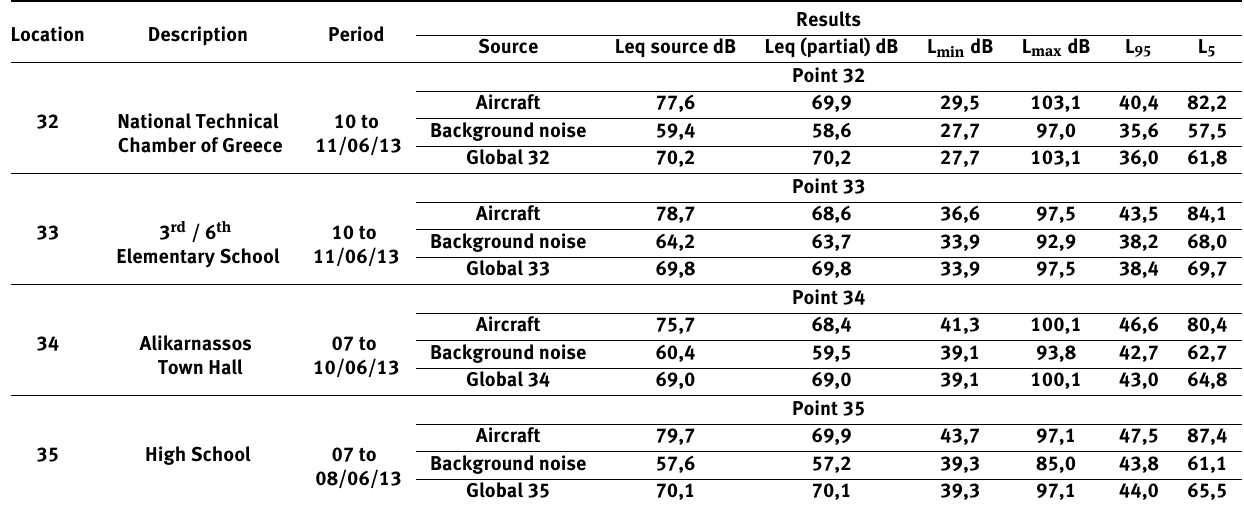
Fig. 6. Study area of Alikarnassos: (a) Sound signals and sound marks map and (b) Sound Identity Map. Table 3. 24h measurement at Alikarnassos study